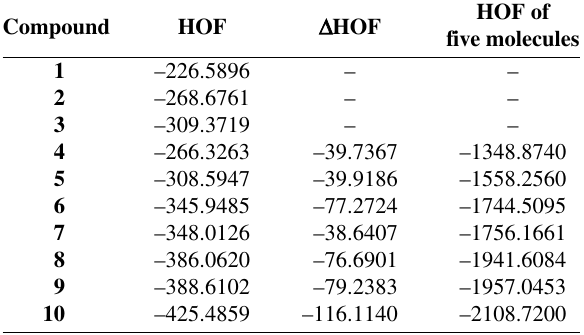
Table 1. Heat of formation (HOF) [ kcal/mol ] of compounds 4 – 10 .